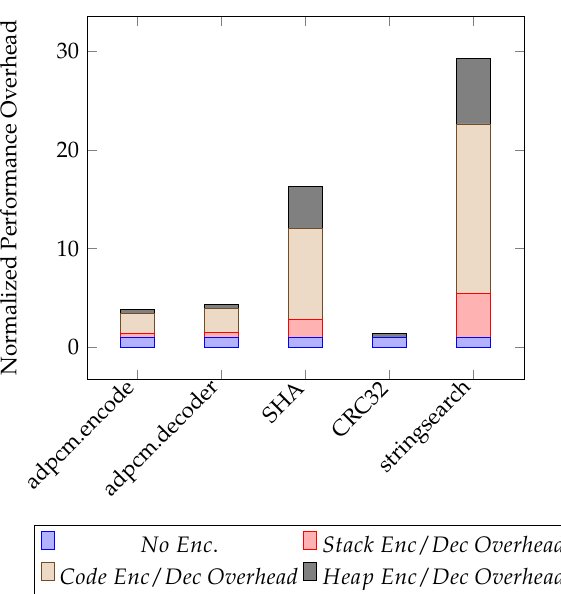
Figure 14. The normalized performance of Enc/Dec.